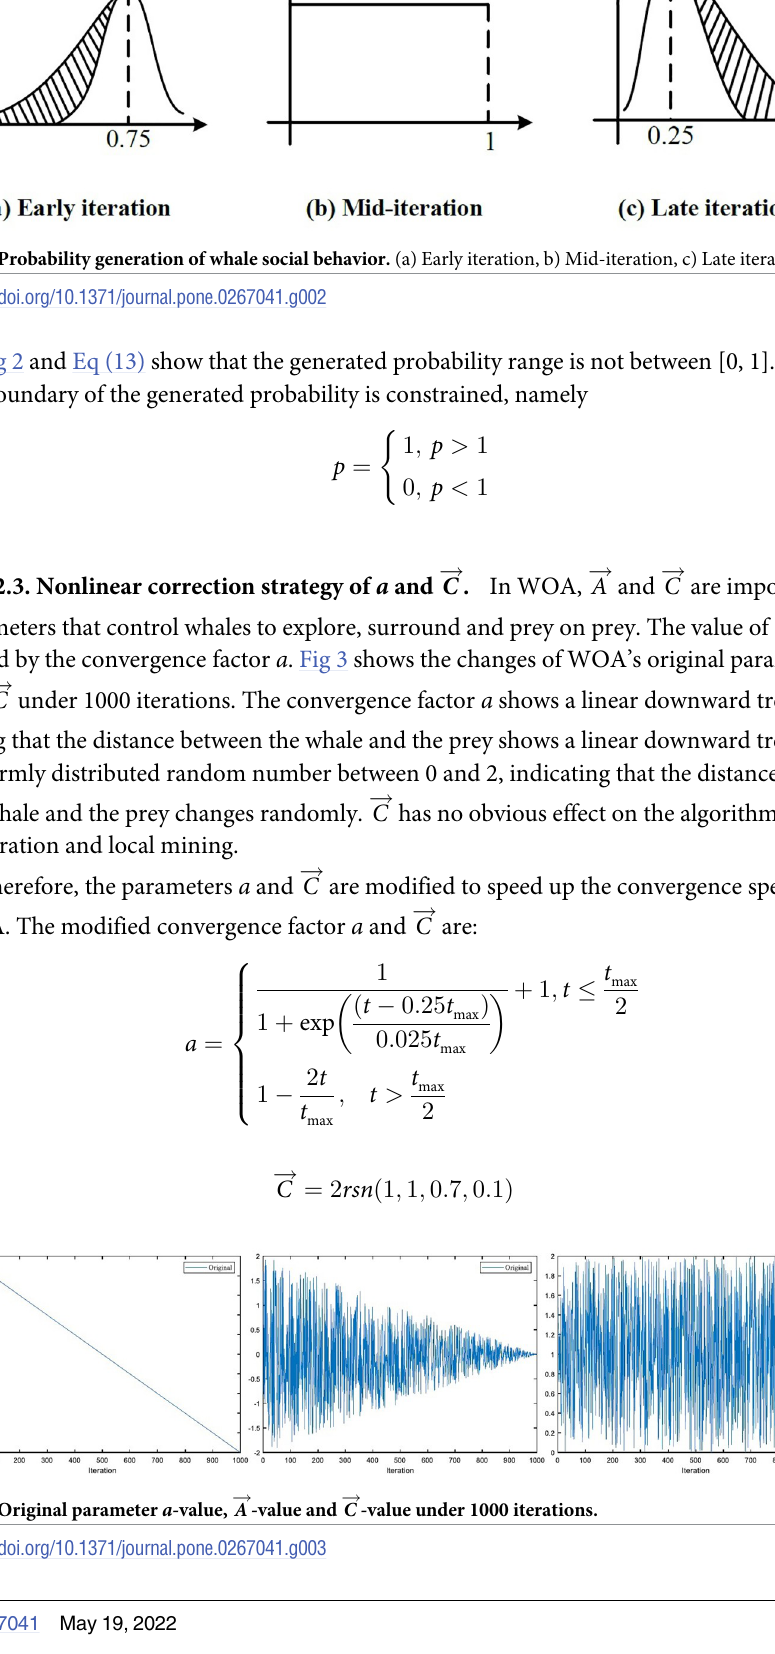
Fig 3. Original parameter a -value, A